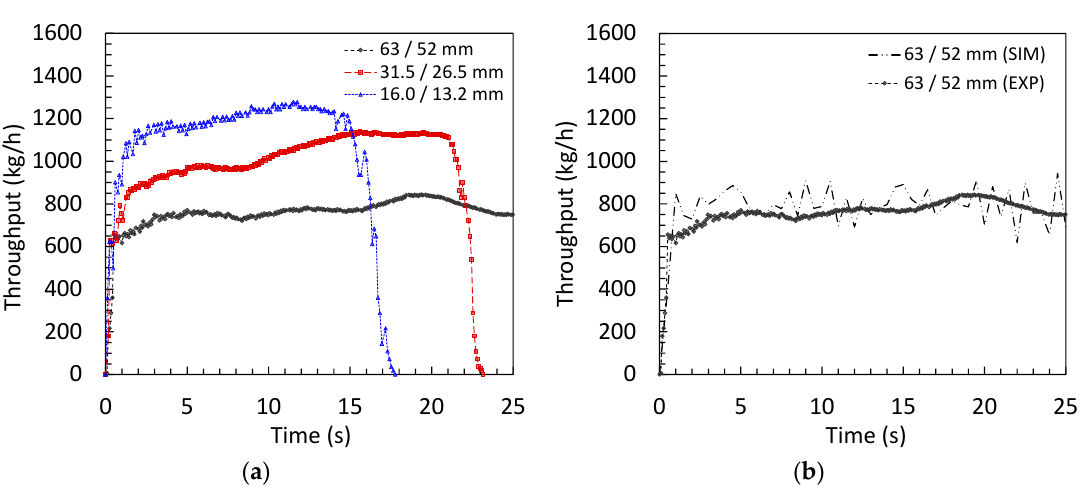
Figure 12. Measured ( a ) and comparison of measured and simulated ( b ) net power of the laboratory jaw crusher.